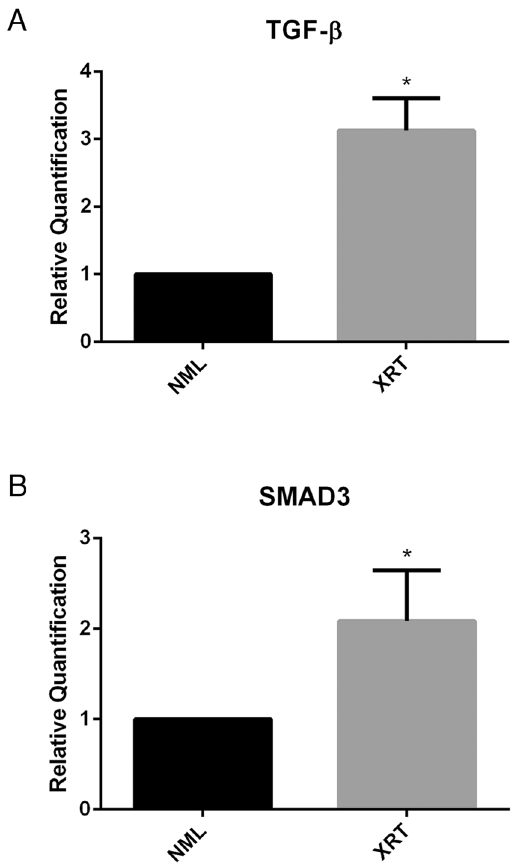
Figure 4. Relative quantification of ( A ) TGF- β and ( B ) SMAD3 expression in irradiated and non-irradiated murine skin samples, quantified by